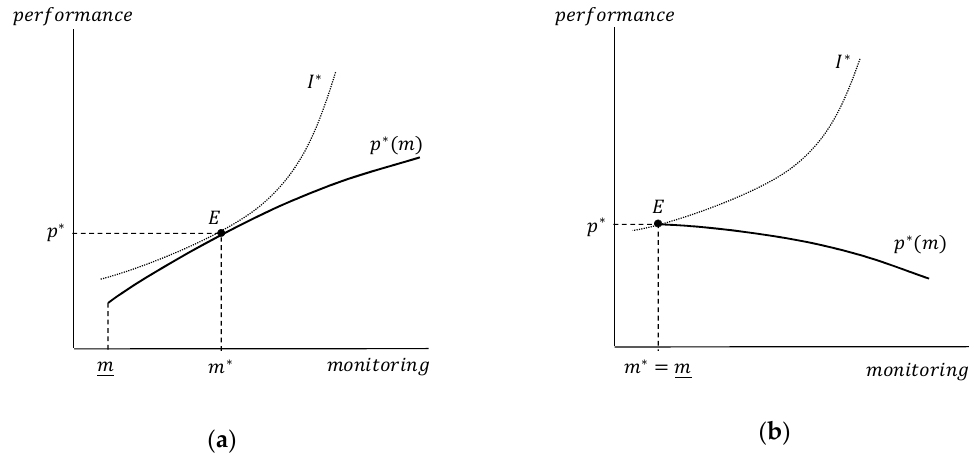
Figure 1. ( a ) “Crowdable-in” case; ( b ) “crowdable-out” case.